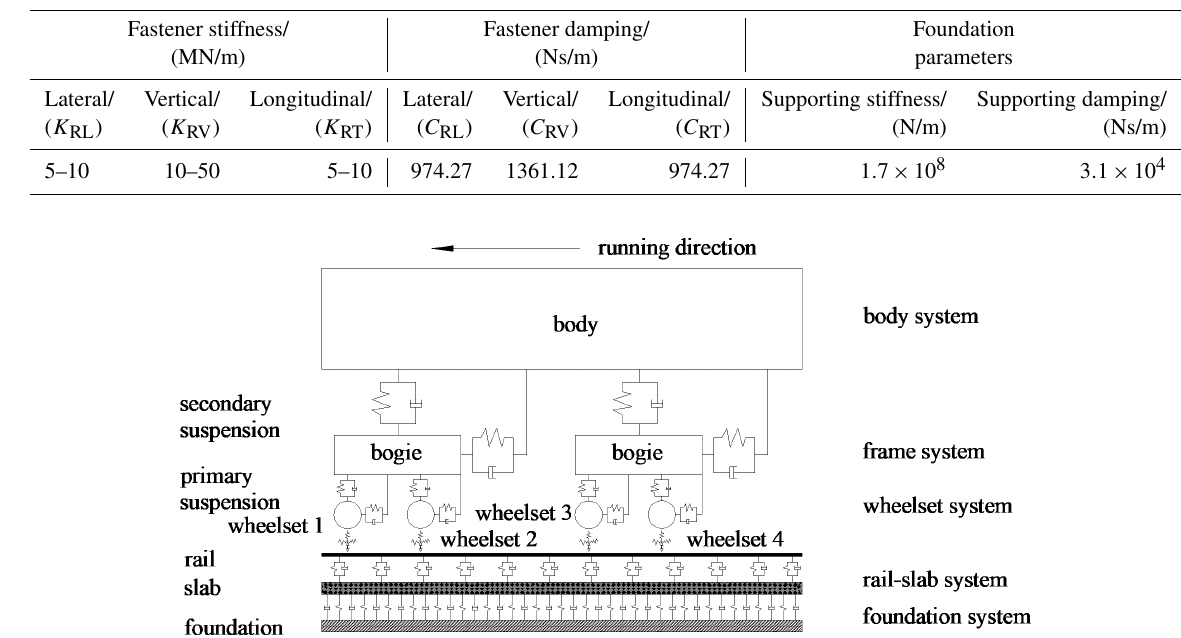
Figure 1. Diagram of the vehicle–track space coupled dynamic